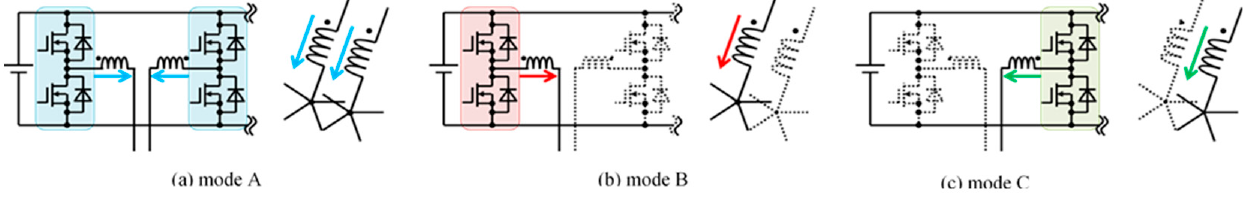
Figure 6. Possible driving methods. ( a ) Mode A is a high-torque mode in which both windings are used, however, the EMF